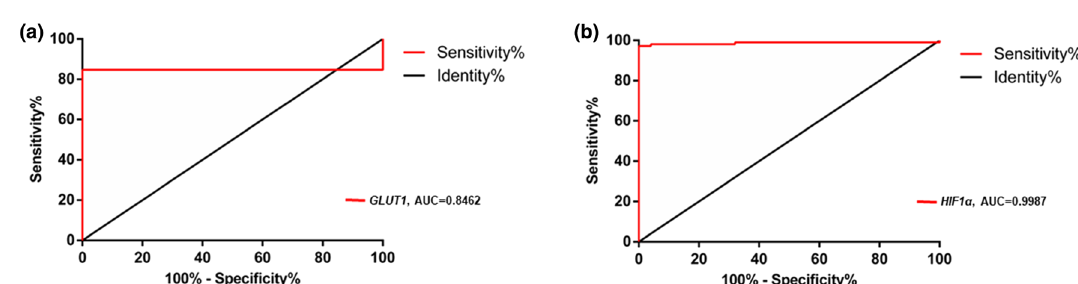
Figure 2. Analysis of the ROC curve to evaluate the accuracy of GLUT1 ( a ) and HIF-1α ( b ) gene expression detection in the blood as a predictive marker for the diagnosis of breast cancer. For GLUT1, AUC = 0.8462 (95% CI 0.7808–0.9115; p < 0.0001), cut-off value of 2 −ΔCq > 0.00017, sensitivity of 84.62% (95% CI 76.78–90.62%) and specificity of 92.31% (95% CI 74.87–99.05%); for HIF-1α, AUC = 0.9987 (95% CI 0.9683–1007; p < 0.0001)], with the cut-off value of 2 −ΔCq > 0.004938, with a sensitivity of 98.15% (95% CI 93.47–99.77%) and a specificity of 96% (95% CI 79.65–99.90%). Gene expression was accessed by 2 −ΔCq formulae before the beginning of the